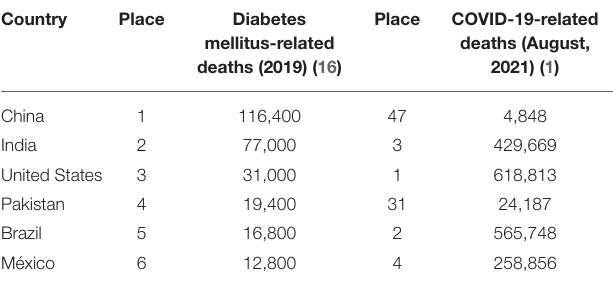
TABLE 1 | Number of diabetes mellitus and COVID-19 related deaths.